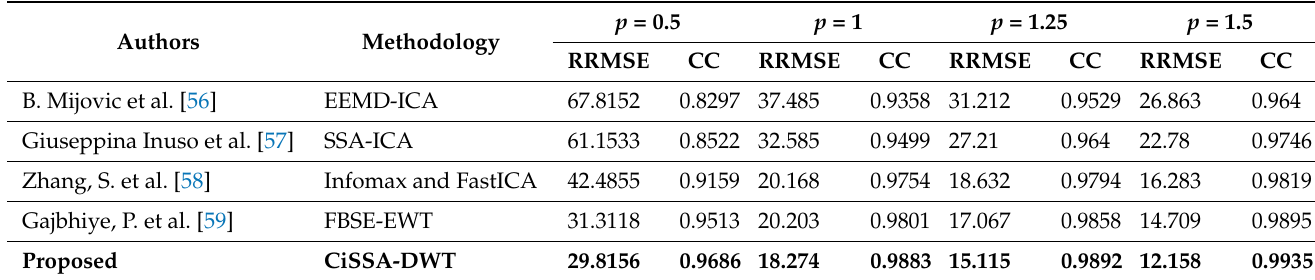
Table 4. Comparison of proposed method RRMSE and CC values with existing methods.